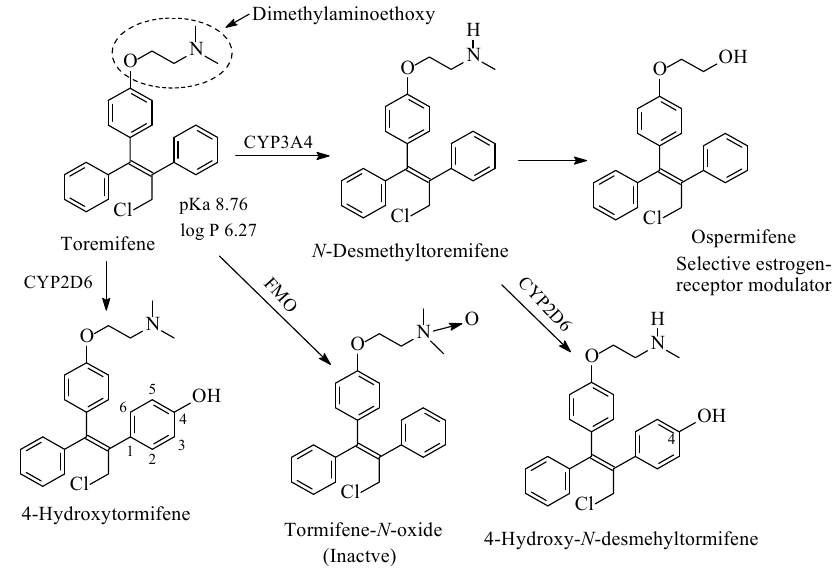
Figure 43. Metabolic pathways of tormifene.